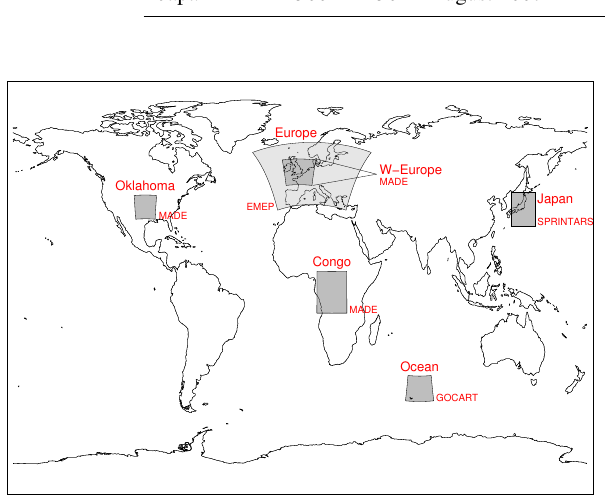
Figure 1. Three models were used in this study to simulate a variety of aerosol fields. The regional names used to identify these simula- tions are given in large font, while the models are denoted in small font. MADE and GOCART refer to the WRF-Chem version used.